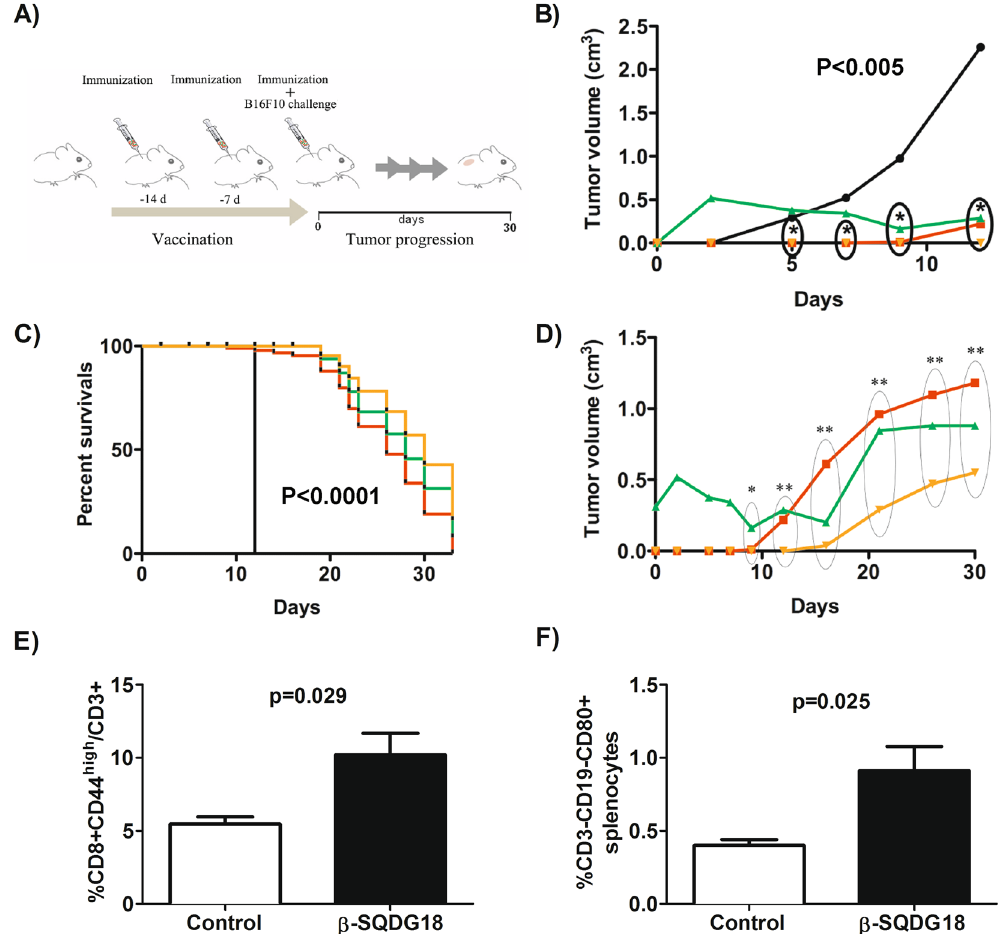
Figure 4. Protective effect of hgp100 25–33 peptide formulated with s ynthetic β -SQDG18 as adjuvant in an experimental model of anti-melanoma vaccine. ( A ) Experimental design of immunization in C57BL/6 J mice challenged by 10 5 B16F10 melanoma cells (day 0). The animals were pretreated with the adjuvanted antigen hgp100 25–33 peptide (100 μ g mouse/injection) on days − 14, − 7 and 0. For the experiment with β -SQDG18 (600 μ g mouse/injection), the antigen was vigorously mixed with a homogeneous suspension of the molecule prior to injection. Mice immunized with the melanoma epitope in association to either CPG oligodeoxynucleotide (30 μ g/injection) or Freund’s adjuvants (1:1 vol/vol) were used as positive controls. Unimmunized mice were used as negative control. Tumour volume of melanoma lesions and survival rate were monitored for 30 days after challenging. Each group was composed of eight animals; ( B ) Tumour growth and ( C ) percent survival in the four groups of mice. Statistically significant difference between the negative control and each of the three immunized groups of mice is indicated. Black line: negative control; Red line: antigen plus β -SQDG18; Green line: antigen plus Freund’s adjuvant; Orange line: antigen plus CpG; ( D ) Detail of tumour growth in response to vaccination with the three adjuvants. Groups are indicated by colours as above Asterisks indicate statistically significant differences in comparison to negative control. * P < 0.01; ** P < 0.002; ( E ) Percentage of CD8 + CD44 high memory T cell in splenocytes of tumour-challenged mice in the negative control group or after vaccination by β -SQDG18 as adjuvant (black column); ( F ) Percentage of CD3-CD19-CD80 + cells in splenocytes of tumour challenged mice in the negative control group and after vaccination by β -SQDG18 as adjuvant (black